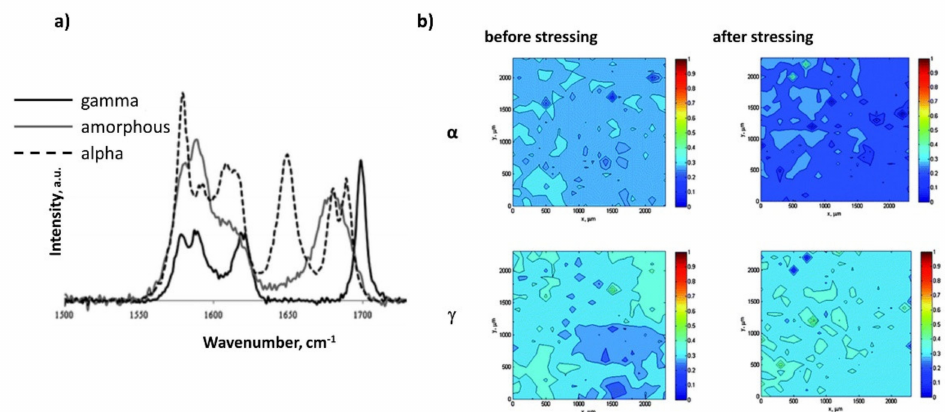
Figure 15. ( a ) Raman spectra of alpha and gamma and amorphous indomethacin; ( b ) distribution of crystalline indomethacin alpha and beta loaded in SBA-15 and the effect of stressing it at high temperature and humidity as the results of PLS analysis at each measurement point of the Raman mapping. Adapted with permission from [223], Copyright 2011